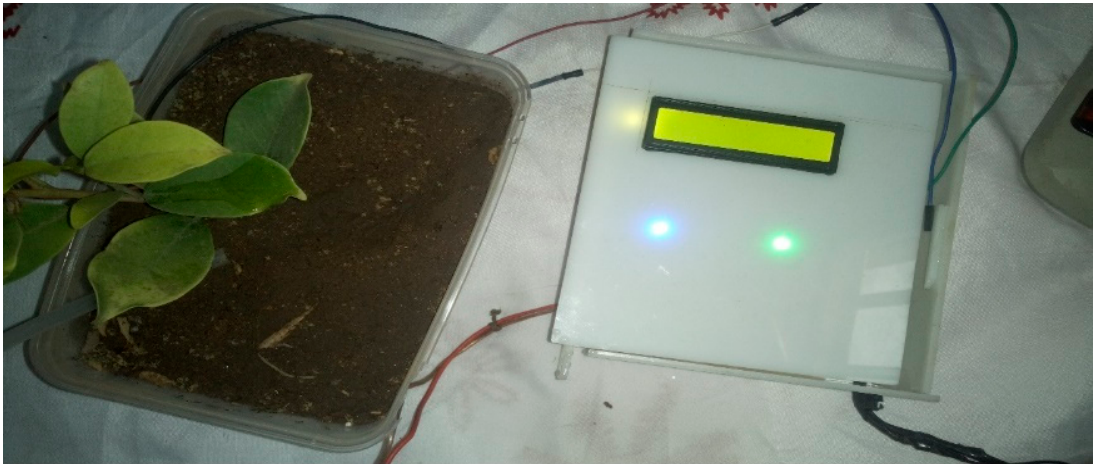
Figure 8. Prototype testing in less moist soil (Moisture level 25%).